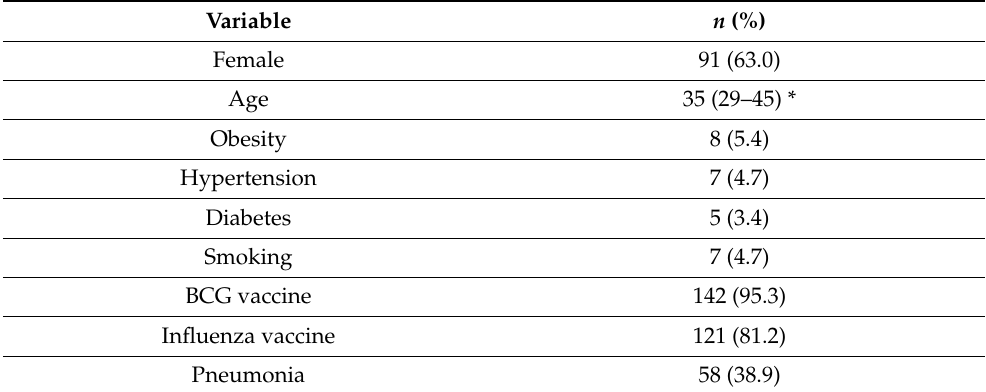
Table 1. Clinical characteristics and comorbidities were initially reported by the patients